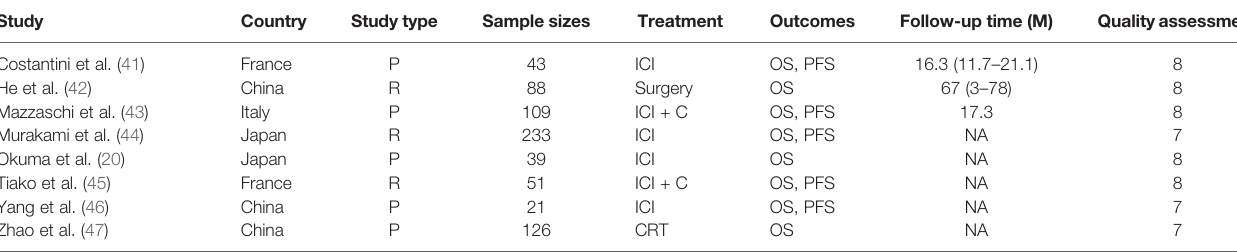
TABLE 1 | Information on the included studies and quality assessment.